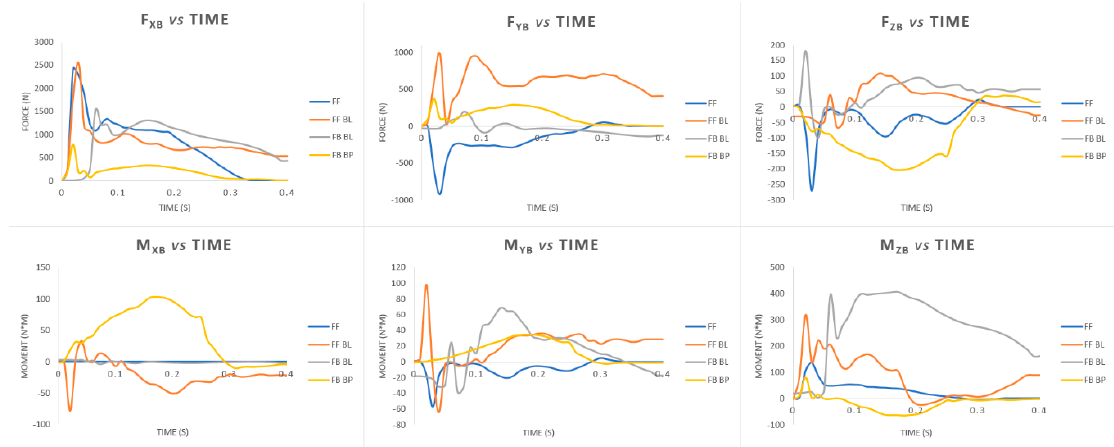
Figure 8. Plots of forces and moments vs. time calculated for different fall scenarios: Fall Forward (FF), Fall Forward with Balance Loss (FF BL), Fall Backwards with Balance Loss (FB BL), Fall Backwards “By Push” (FB BP).